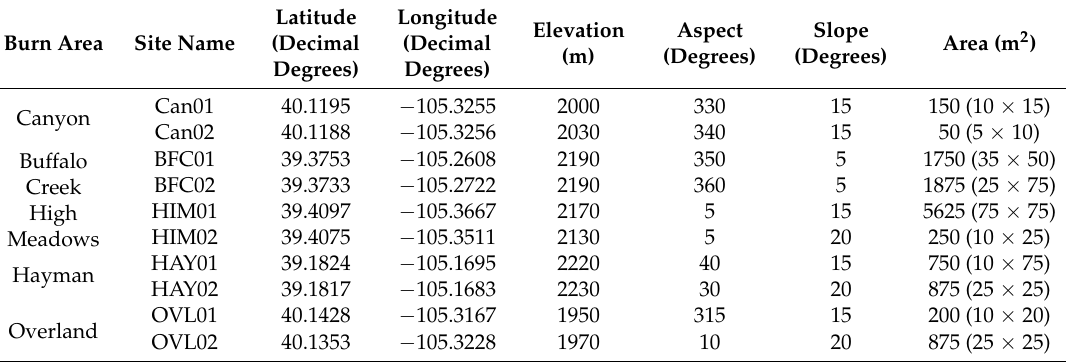
Table 1. Description of the ten sampling sites included in this study. All sites are located in the lower montane zone of the Colorado Front